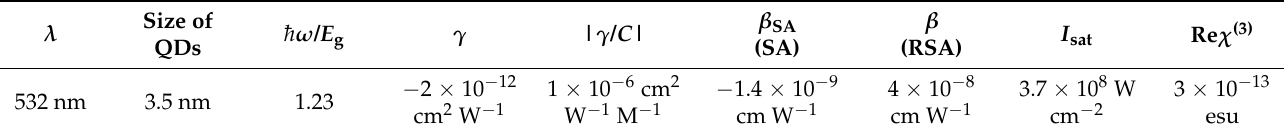
Table 1. Summary of the nonlinear optical measurements of InP@ZnS CQDs. λ is the wavelength of probe pulse (532 nm), ¯ h is the Planck’s constant, ω is the frequency of laser radiation, E g is the energy band gap of studied QDs, γ is the nonlinear refractive index, C is the molar concentration, β SA is the nonlinear absorption coefficient attributed to saturable absorption, β is the nonlinear absorption coefficient attributed to reverse saturable absorption, I sat is the saturated intensity, and Re χ (3) is the real part of third-order nonlinear susceptibility. Size λ